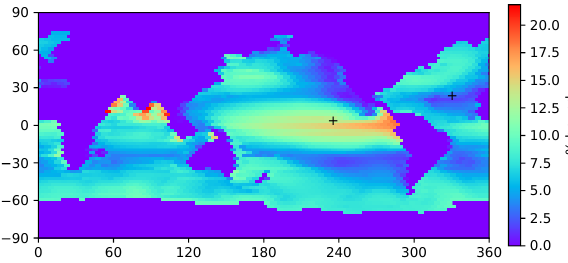
Figure 4. A map of the bound fraction of Hg(II) (relative to bound + unbound), at the sea surface, when the K × 10 6 . Higher d value is 2 POC concentrations in productive regions lead to higher bound frac- tions of the Hg(II). Plus signs indicate the locations of profiles in Figs. 3, 8, 12, 14, and 15. Figure 5. Depth profiles (in meters) of the bound fraction of Hg(II) from the same locations as in Fig. 3, as a function of the K d value, preanthropogenic steady state (1850). A value of 2 × 10 6 Lkg − 1 POC (blue lines) is used in the rest of the model